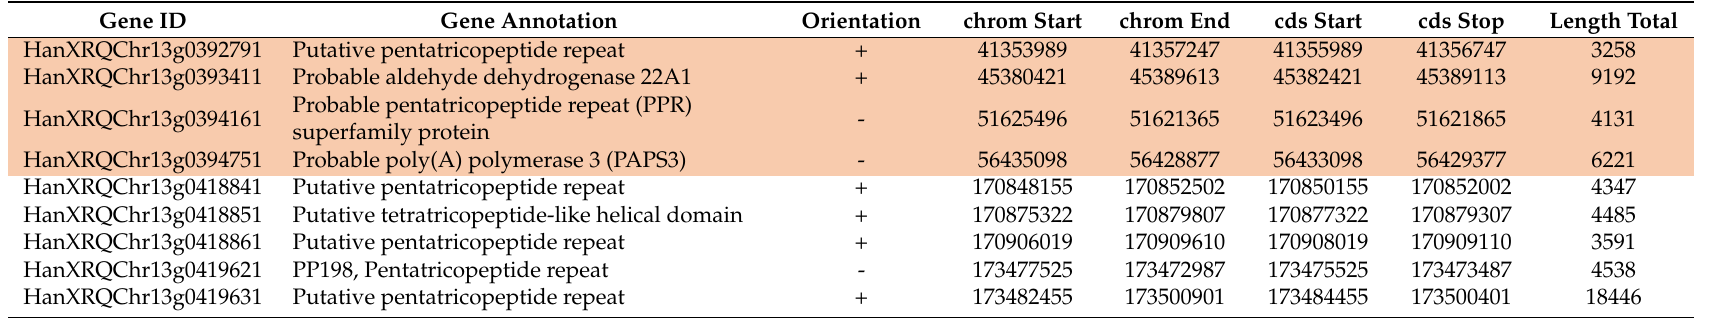
Table 2. Potential candidate genes for the restorer gene Rf1 on chromosome 13.